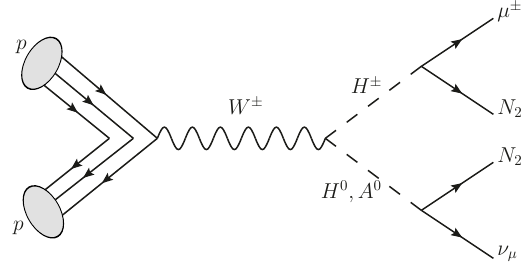
Figure 34 . Feynman diagram for the production of µ ± + /E T final state at LHC (Toy Model I).